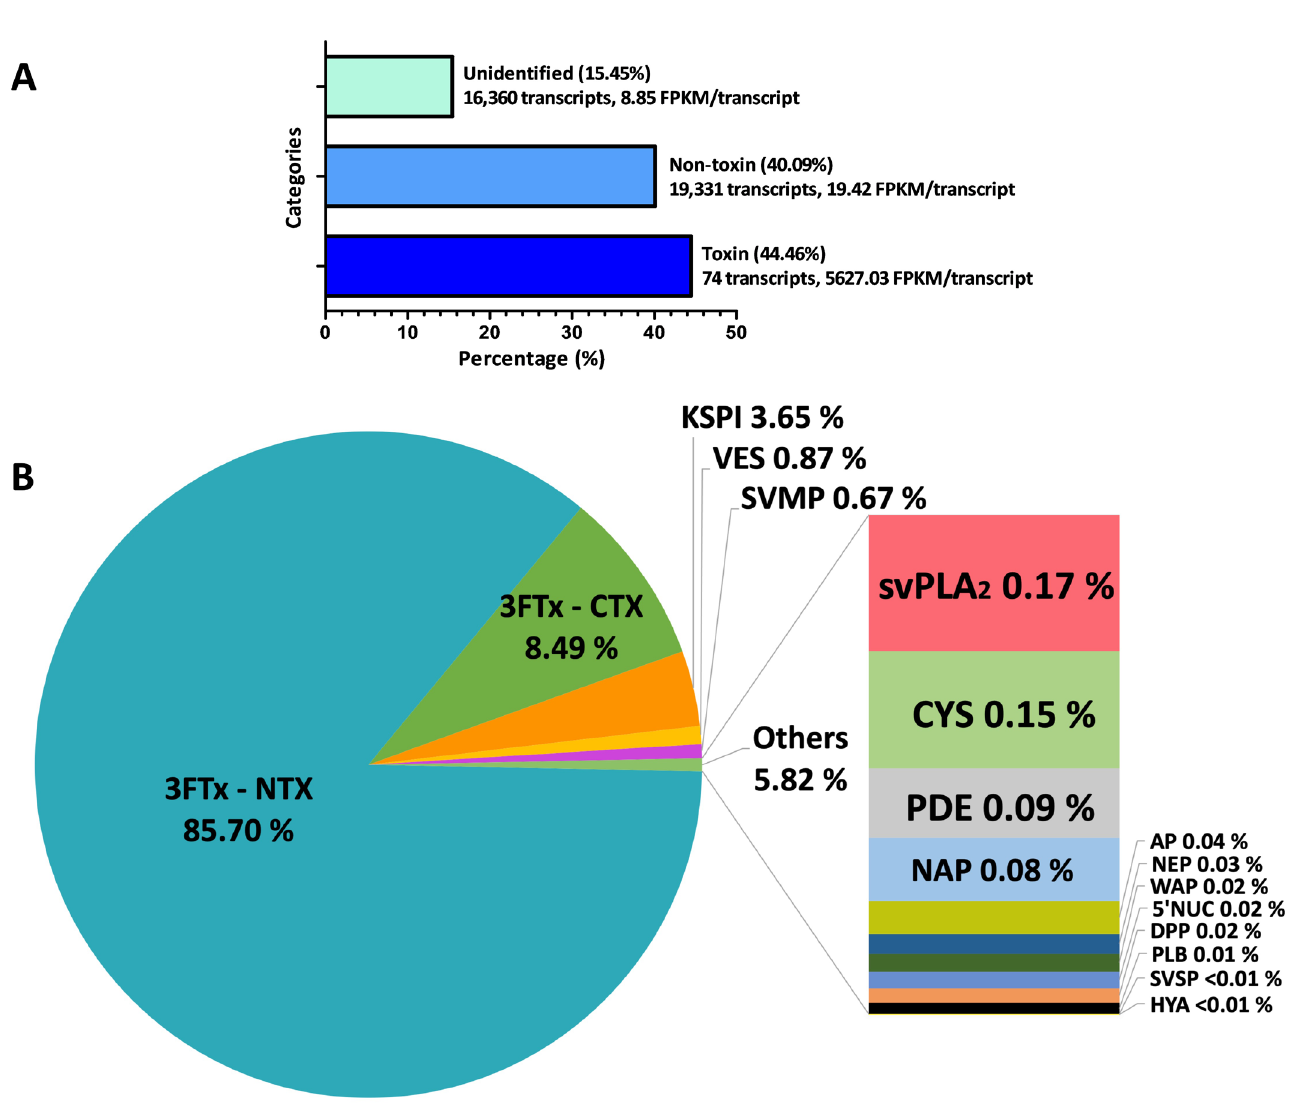
Figure 2. Venom gland transcriptome of Calliophis bivirgata flaviceps from Malaysia. (A) Abundance (in percentage of total FPKM) and redundancy (average FPKM/ transcript) of transcripts according to “toxin”, “non-toxin” and “unidentified” categories. (B) Expression profile of toxin transcripts according to protein families (in percentage of total toxin FPKM). The percentages indicate the relative abundances of transcripts based on expression levels in FPKM, as outlined in the method. FPKM: fragments per kilobase of transcript per million mapped reads; 3FTx: three-finger toxin; NTX: neurotoxin; CTX: cytotoxin; KSPI: Kunitz-type serine protease inhibitor; VES: vespryn; SVMP: snake venom metalloproteinase; svPLA : snake venom phospholipase A ; CYS: cystatin; PDE: phosphodiesterase; NAP: natriuretic 2 2 peptide; AP: aminopeptidase; NEP: neprilysin; WAP: waprin; DPP: dipeptidyl peptidase; 5’NUC: 5’nucleotidase; PLB: phospholipase B; SVSP: snake venom serine protease; HYA: